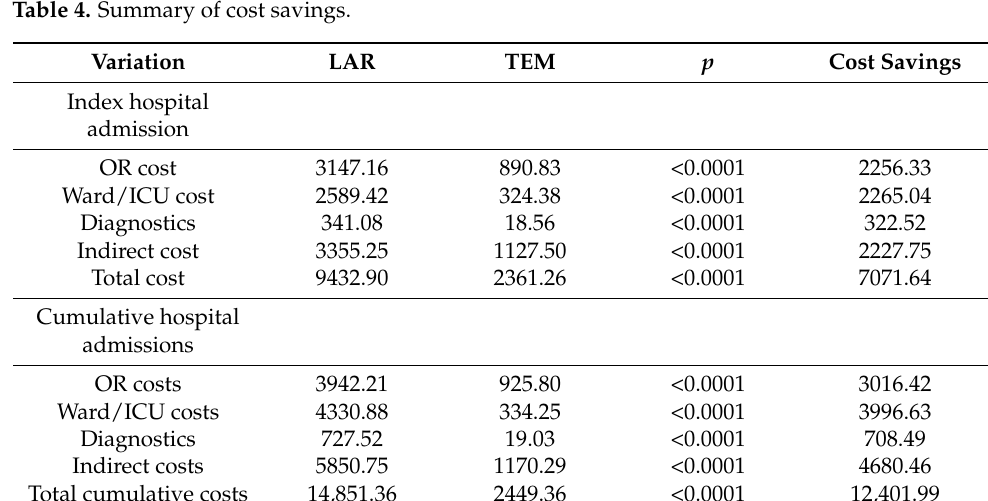
Table 4. Summary of cost